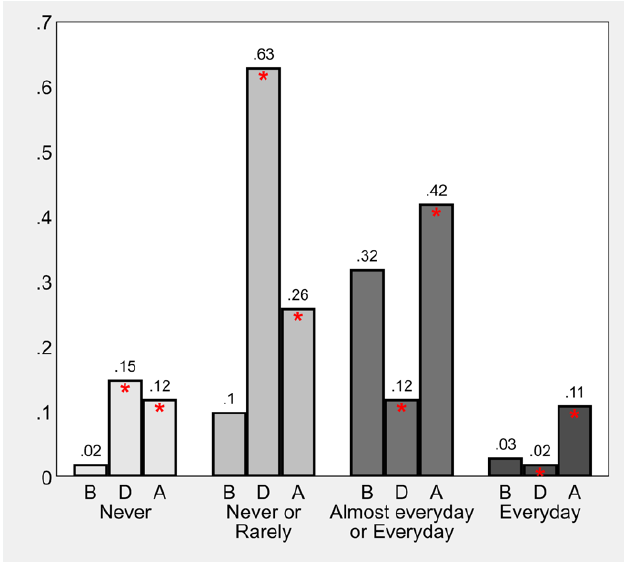
Figure 2. Frequency of child sport participation before (B), during (D), and after (A) Italy’s national lockdown. Point estimates of proportions derive from multilevel mixed-effects generalized ordered probit regression; * indicates a significant increase or decrease relative to B ( p -value ≤ 0.05).